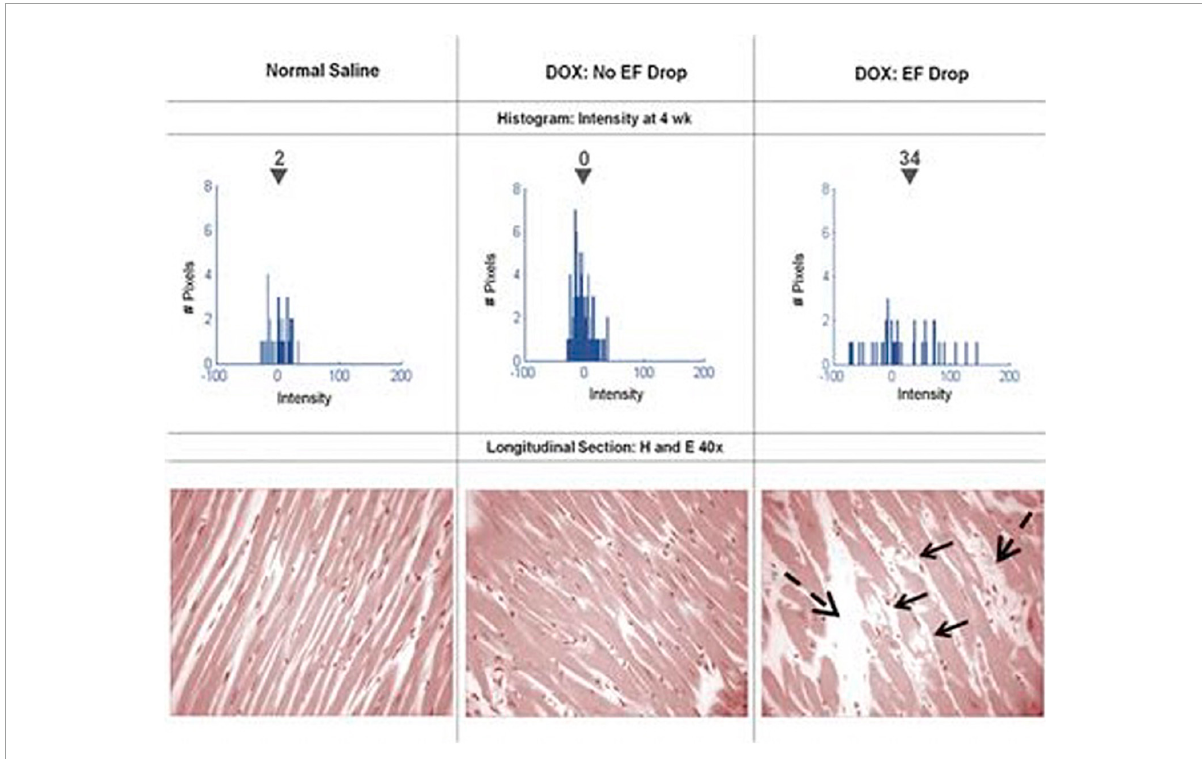
FIGURE6 Serial histograms of myocardial LGE signal intensity ( top , mean intensity shown above the inverted black triangles ) and corresponding histopathology (bottom) of individual animals 4 weeks after receipt of normal saline (left) , doxorubicin without an LVEF drop (middle) , and doxorubicin with an LVEF drop (right) . Vacuolization ( arrows ) and increased extracellular space ( dashed arrows ) were observed in animals with doxorubicin cardiotoxicity. From Lightfoot et al. (53) with